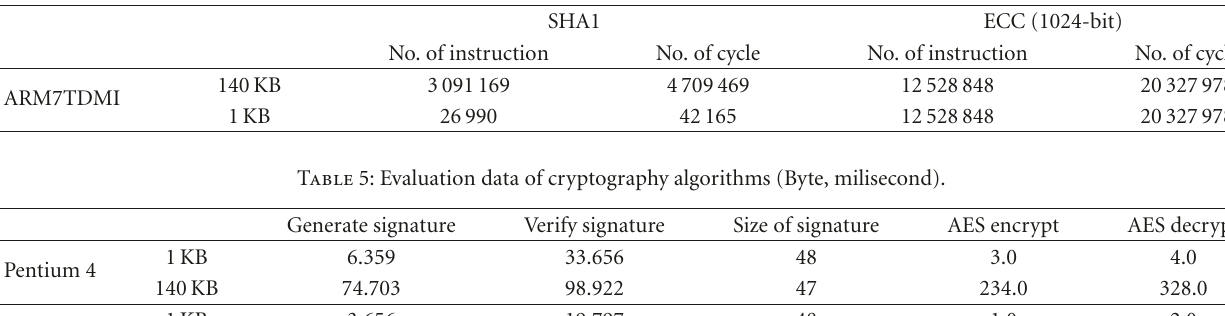
Table 4: Number of instructions and cycles required for the digital signature.